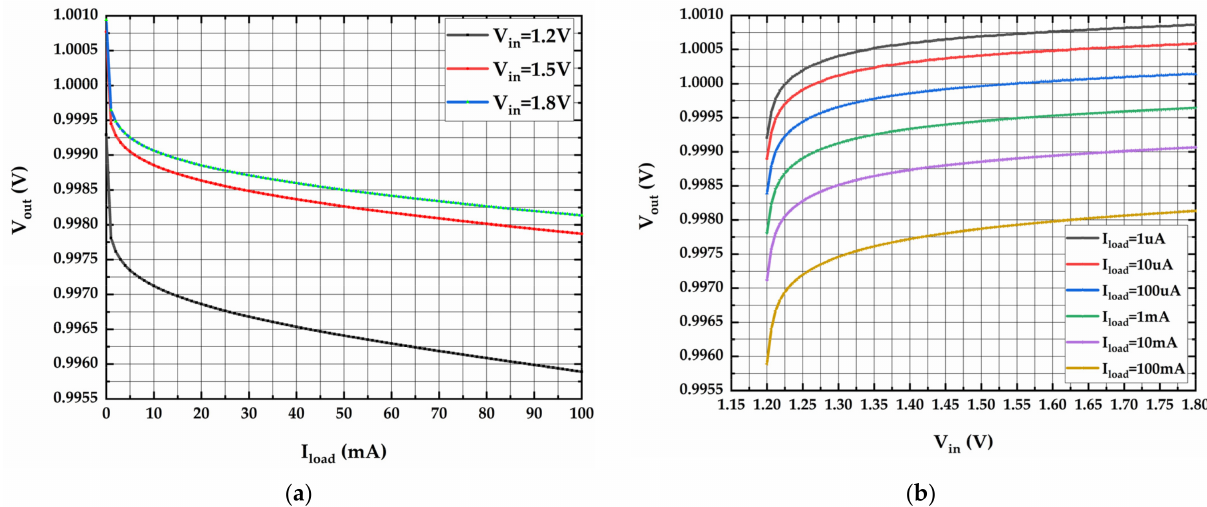
Figure 11. ( a ) Simulated load regulation for V in = 1.2 V, V in = 1.5 V, and V in = 1.8 V when V OUT = 1 V; ( b ) Simulated line regulation for different load currents (from 1 µ A to 100 mA) when V OUT = 1